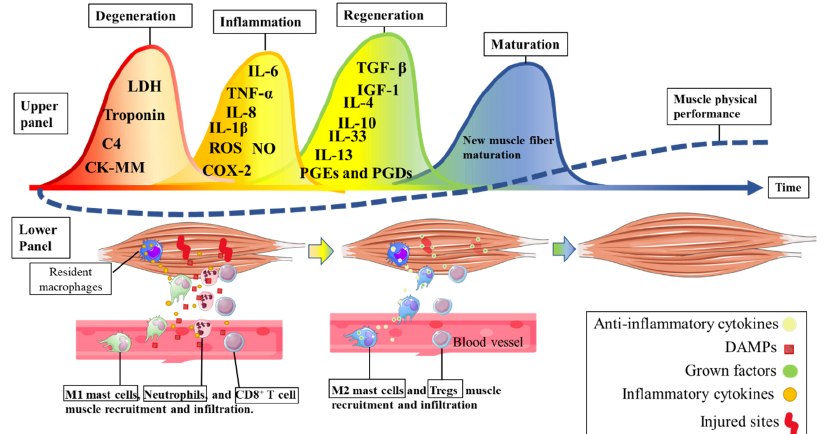
Figure 3. The immunological response to a strenuous bout of physical exercise. In the upper panel, the different processes (five waves) induced by muscle injury during and after physical exercise are described. The lower panel describes immune cell recruitment after muscle cell injury. Acronyms: Complement C4, C4; CK, creatine kinase; LDH, lactate dehydrogenase; COX-2, ciclooxigenase-2; IGF1, insulin grow factor-1; IL, interleukin; PGE and PGD, prostaglandins E and D, respectively; TGF- β , transforming growth factor-beta; TNF, tumor necrosis factor.